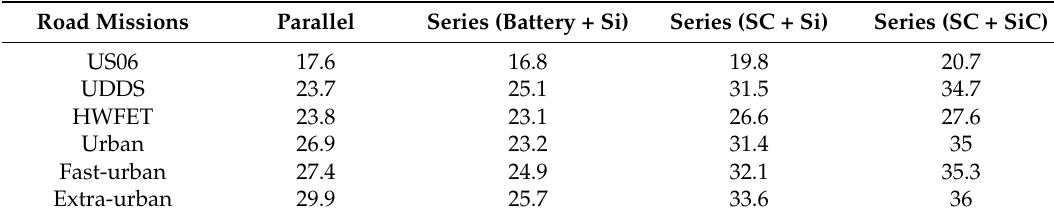
Table 8. Fuel economy